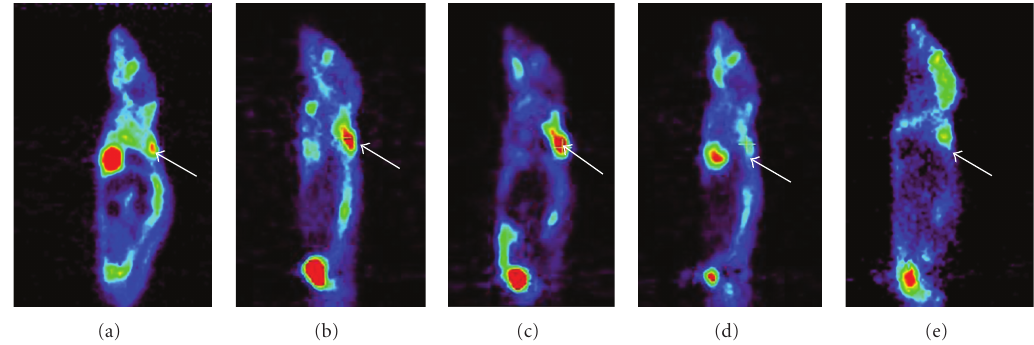
Figure 1: Comparison of interscapular BAT uptake in mice receiving di ff erent interventions from microPET sagittal images. For visual analysis, microPET images showed that mouse interscapular BAT 18 F-FDG uptake (arrow) varied under di ff erent interventions. (c) Cold plus NE interventions showed highest BAT uptake ( R = 15 . 64 ± 5 . 58, P = 2 . 19 × 10 − 6 ) compared to (b) cold exposure ( R = 10 . 22 ± 4 . 13, P = 1 . 96 × 10 − 4 ) and (a) control ( R = 4 . 08 ± 1 . 32), while (d) warming ( R = 2 . 13 ± 0 . 43, P = . 001) and (e) propranolol ( R = 1 . 30 ± 0 . 16, P = . 027) showed decreased BAT uptake in cold pre-exposure mice.